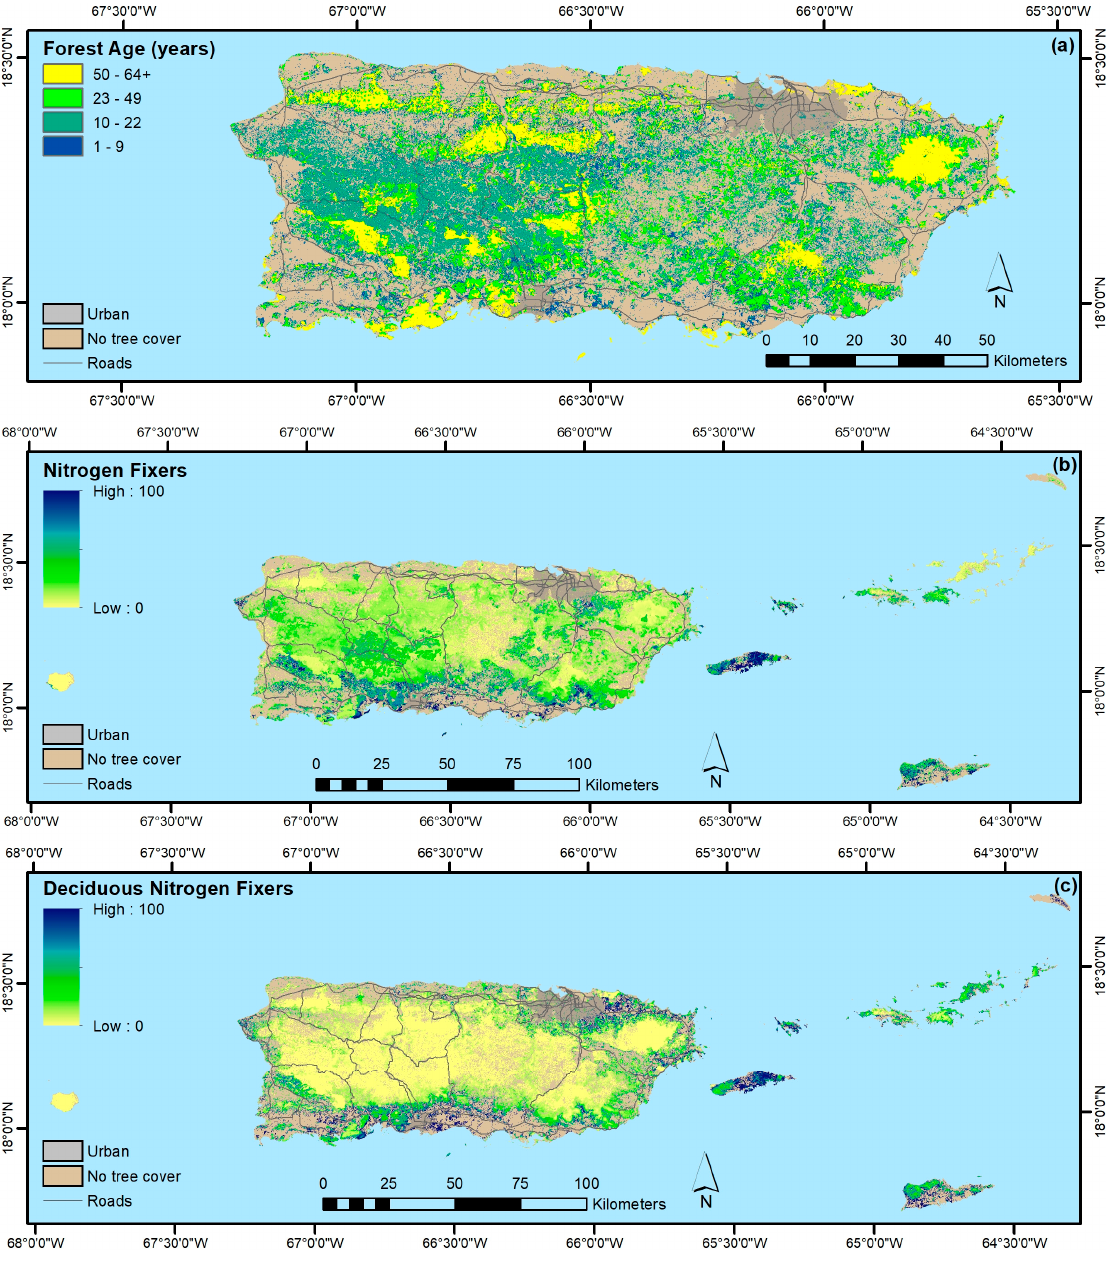
Figure 5. Stand age in Puerto Rico circa the year 2000 ( a ) and relative basal areas, as mapped with Cubist regression tree models, of ( b ) N-fixing species and ( c ) deciduous N-fixing species.